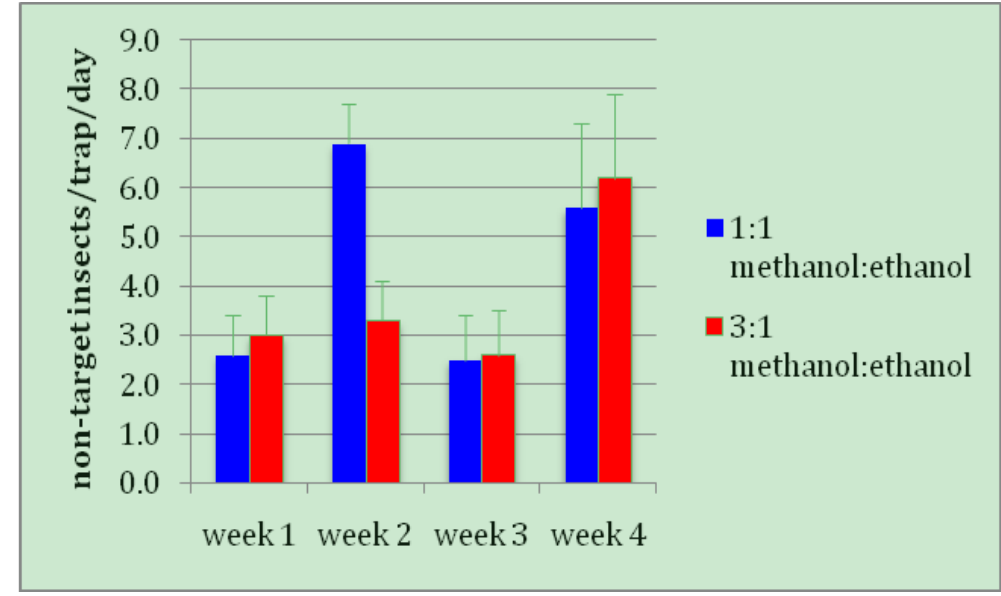
Figure 3. Mean number of non-target adult beetles captured per trap, per day in Brocap traps containing two different ratios of methanol: